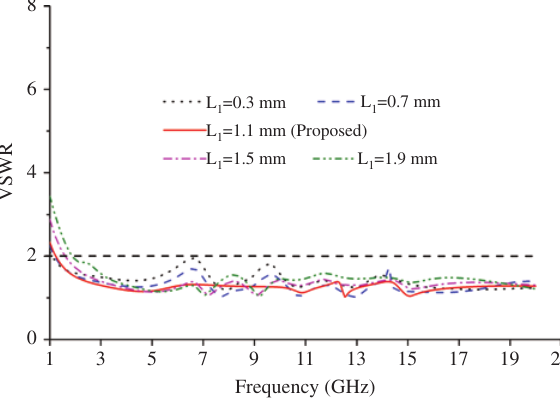
Figure 4: Effects of varying the upper feed width on the heart- shaped radiating